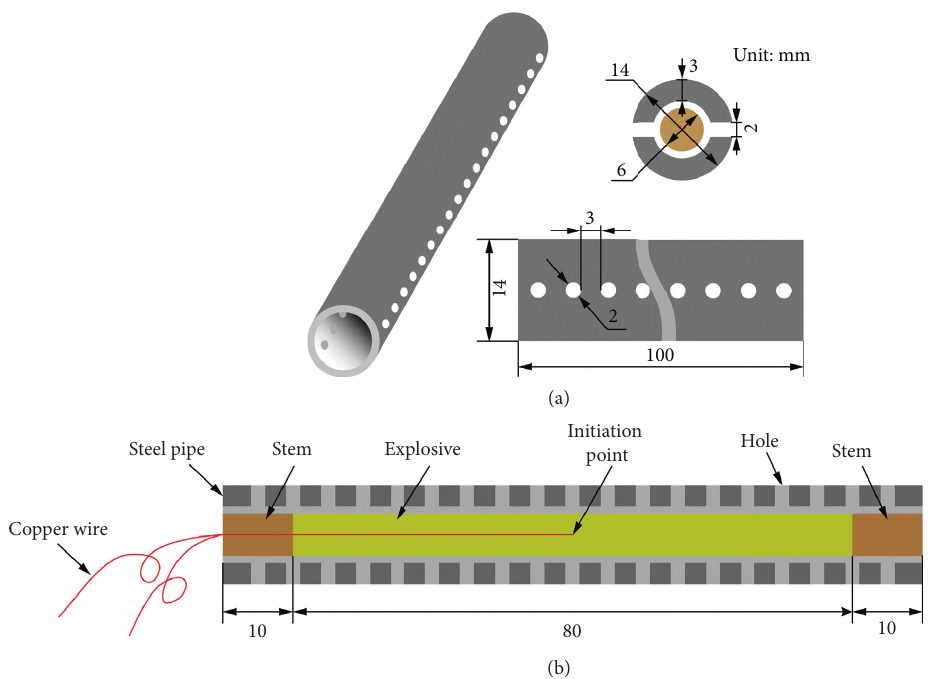
Figure 2: Schematic of the charge holder of a pipe with